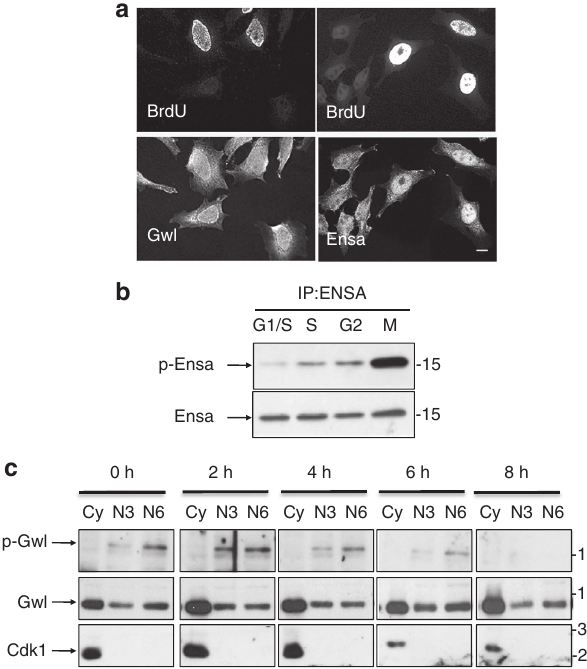
Fig. 6 Gwl and Ensa are active and localised into the nucleus during S phase. a Asynchronous HeLa cells were incubated with BrdU for 30 min and subsequently fi xed and used for immuno fl uorescence with anti-BrdU and anti-Gwl or anti-Ensa antibodies. Scale bar , 10 μ m. b Ensa protein was immunoprecipitated in G1/S, S, G2 or M phase synchronised HeLa cells and used for western blot using antibodies recognising Ensa (Ensa) protein or the phosphosite S67 of this protein (p-Ensa). c HeLa cells were synchronised in S phase by 24 h thymidine incubation and at the indicated times after release, cells were lysed with hypotonic buffer and the cytoplasmic fraction was recovered (Cy). Nuclear pellet was split into two equal parts and resuspended with NETN buffer containing either 300 mM or 600 mM NaCl. After 30 min incubation, samples were centrifuged and supernatants (N3 for 300 mM or N6 for 600 mM) were used for western blots with Cdk1 and anti-phospho Gwl S875 antibodies. Cdk1 levels were used to con fi rm the purity of cytosolic and nuclear